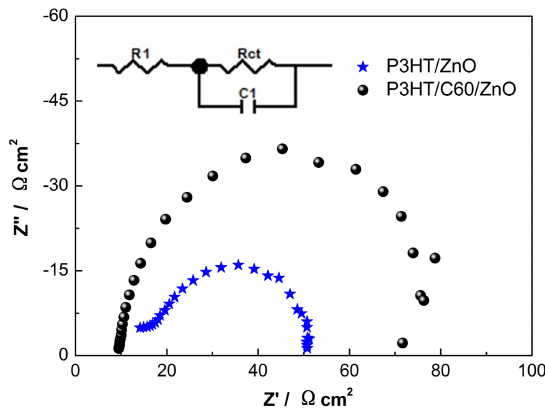
Figure 9. EIS spectra of the hybrid solar cells, inset shows the employed equivalent circuit. Table 2. Parameters related to charge transport and recombination of hybrid solar cells derived from